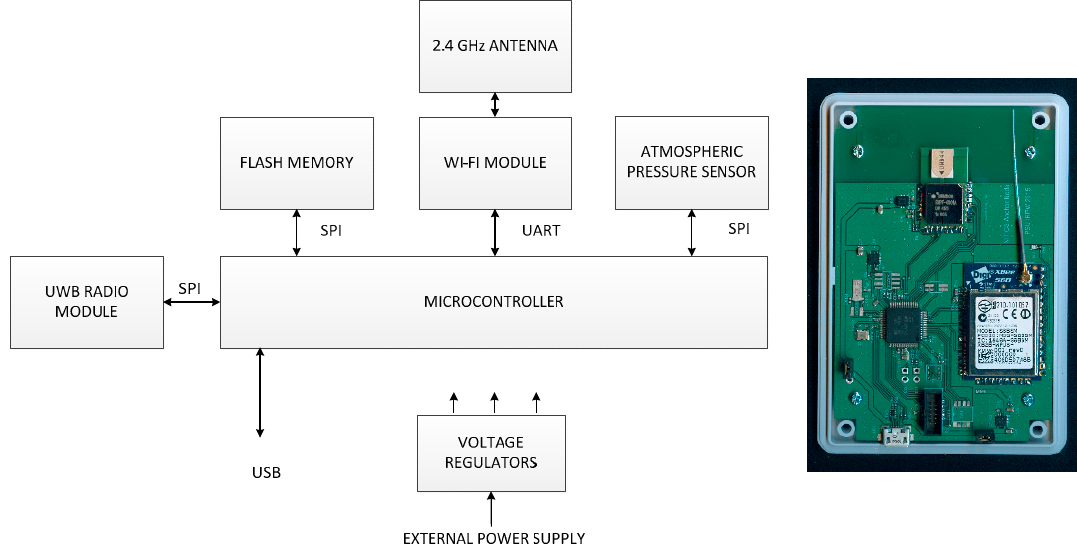
Figure 5. Anchor node/reference node architecture and assembled anchor node board.